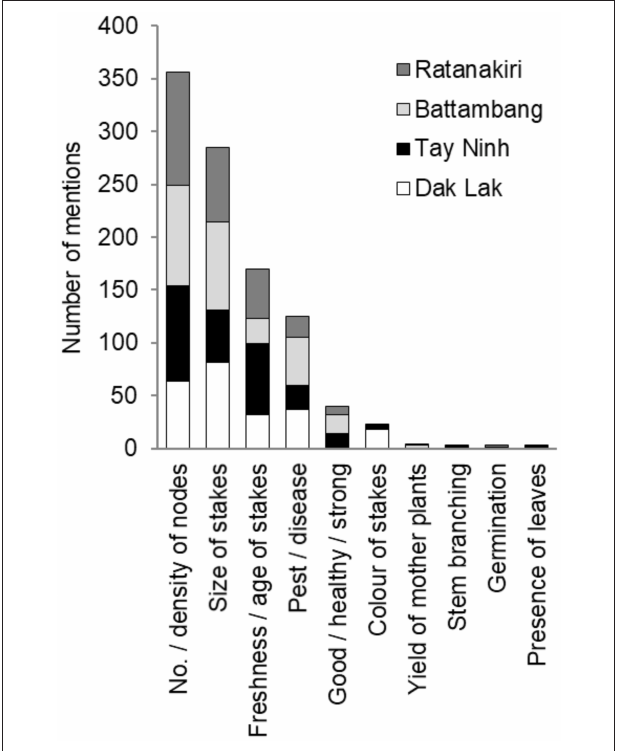
FIGURE 4 | Number of mentions of quality indicators considered during selection of cassava planting material by survey respondents at four subnational survey sampling sites in Vietnam and Cambodia. Responses were free-listed, and thus multiple responses were allowed per respondent. Free-listed responses were categorized into dominant themes post